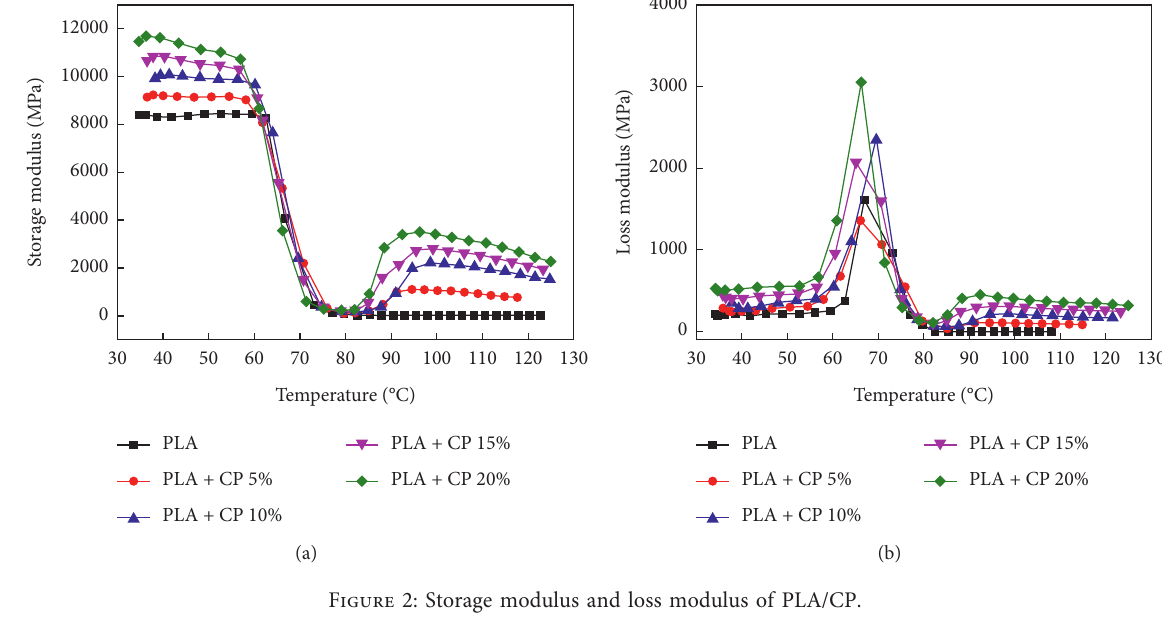
Figure 2: Storage modulus and loss modulus of PLA/CP.